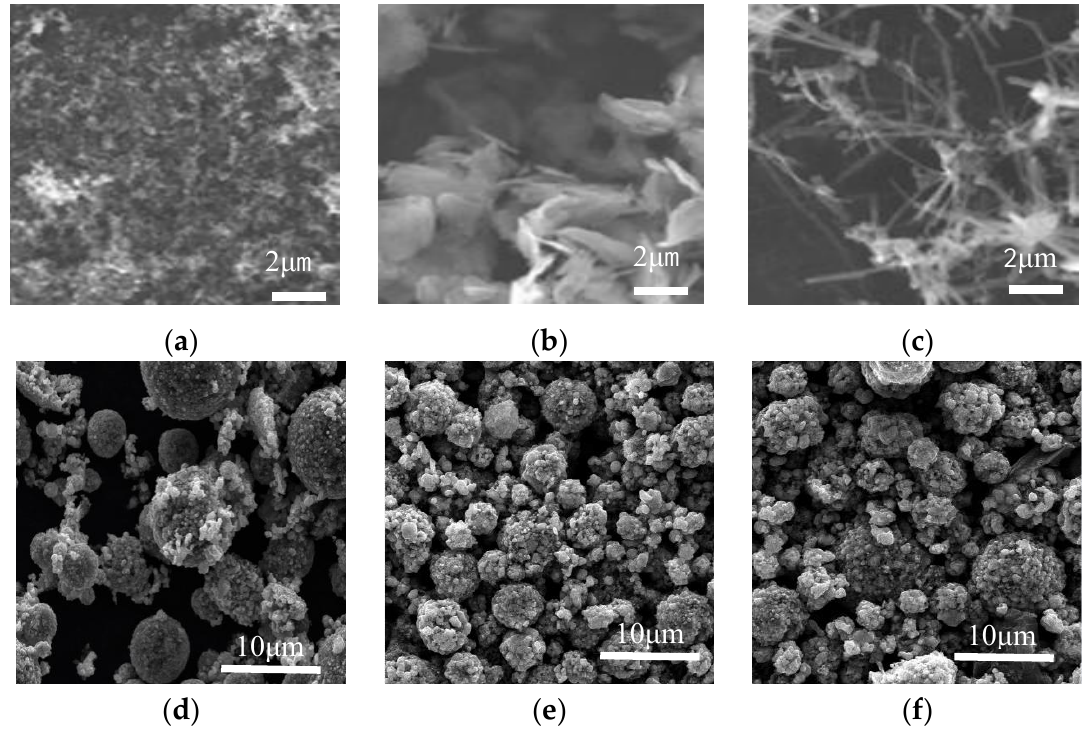
Figure 2. SEM of conductive agents and electrodes with different conductive materials: the surface morphologies of Super-P and KS-15 ( a ); the surface morphologies of graphene ( b ); the surface morphologies of carbon nanotube ( c ); the electrodes image of Super-P and KS-15 ( d ); the electrodes image of graphene ( e ); the electrodes image of carbon nanotubes ( f ).